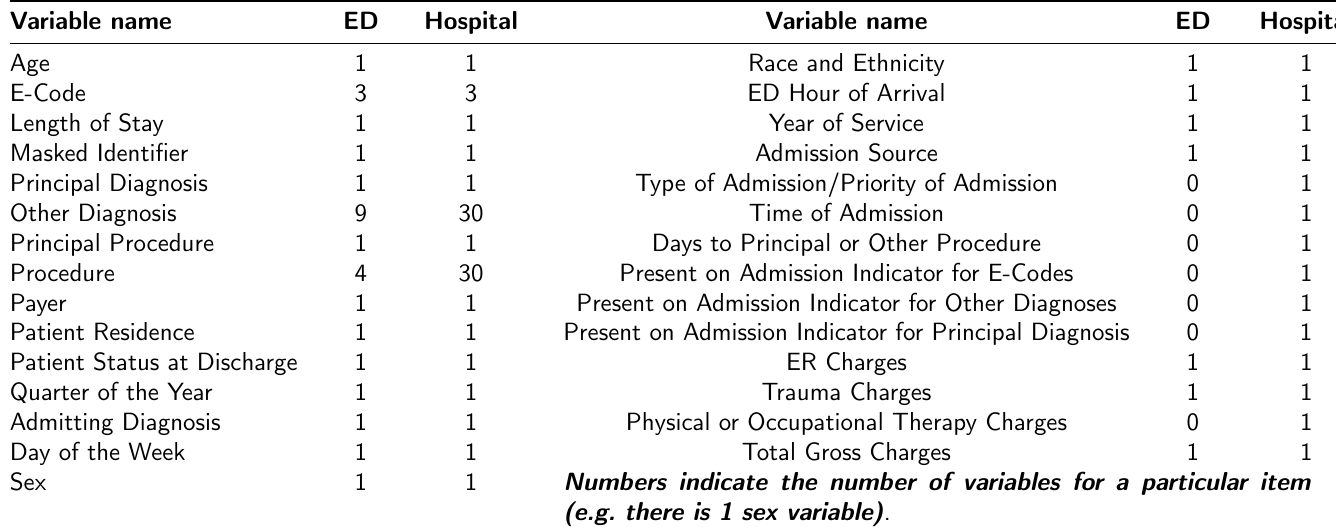
Table 1: Variables included in the longitudinal sports and recreation injury study